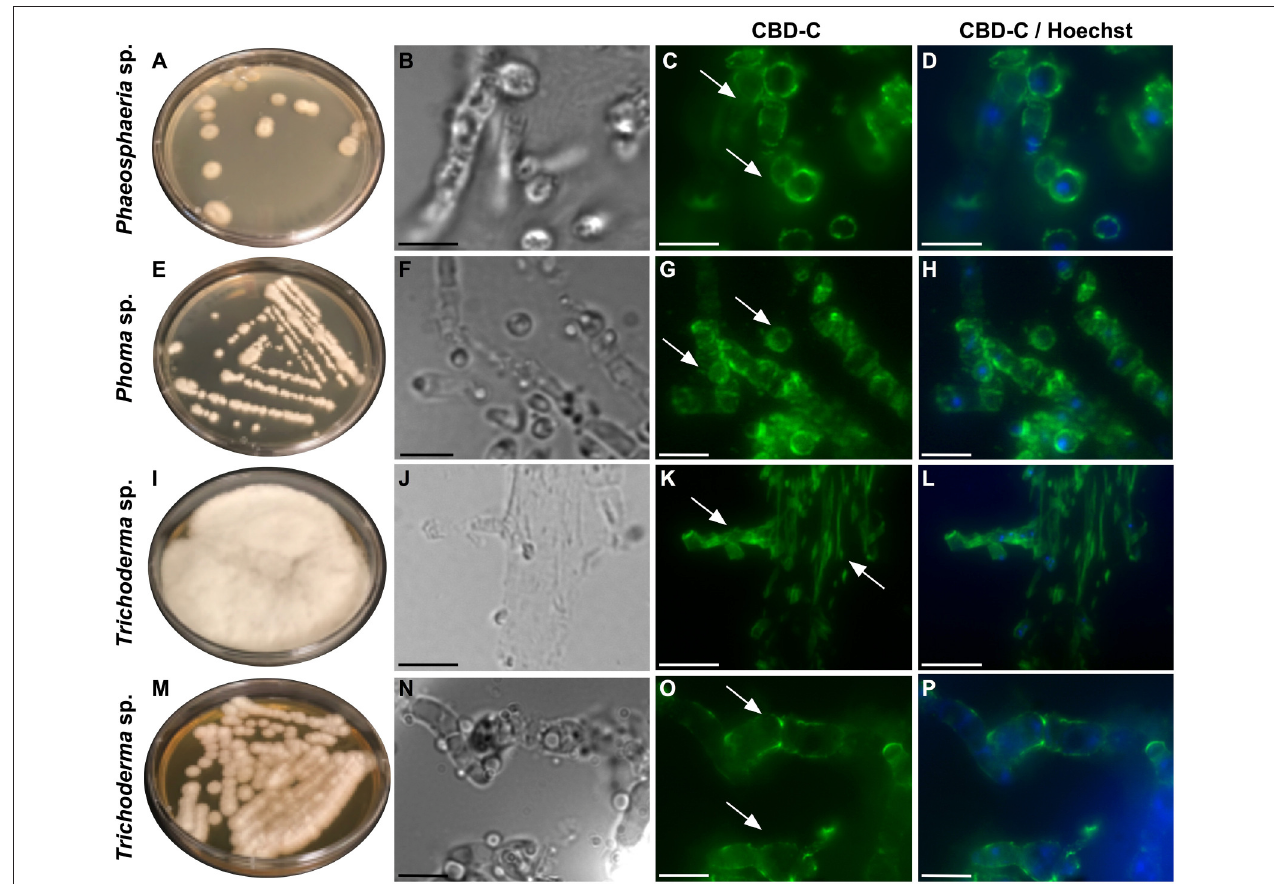
FIGURE 2 | Immunofluorescence with the Fc-CBD-C probe on fungal sections. Fungal species, including Phaeosphaeria sp., Phoma sp., and Trichoderma spp., were isolated from the Ciona gut and grown on YPD agar plates (A,E,I,M) . Immunofluorescent staining, using the Fc-CBD-C probe, on OCT-embedded and cryo-sectioned fungal isolates, indicates that chitin molecules are distributed in the whole cell walls of these fungi ( C,G,K,O , arrows). (B,F,J,N) are brightfield images of fungal sections; (D,H,L,P) represent merged images of the Fc-CBD-C probe (green) and nuclear staining with Hoechst (blue). Scale bars: (B–D,J–L) , 10 µ m; (F–H,N–P) , 5 µ